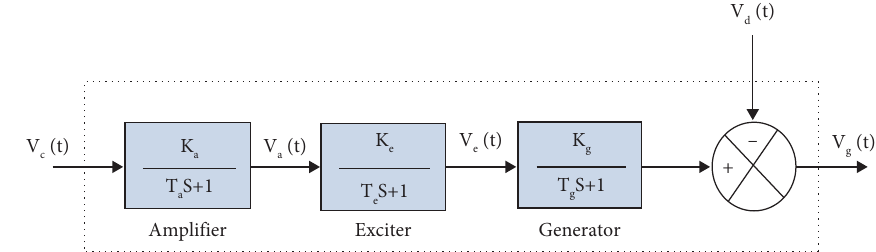
Figure 1: Open-loop schematic diagram of automatic voltage regulator (AVR) with transfer functions. Table 1: Description of AVR components and their ranges [2, 3]. AVR